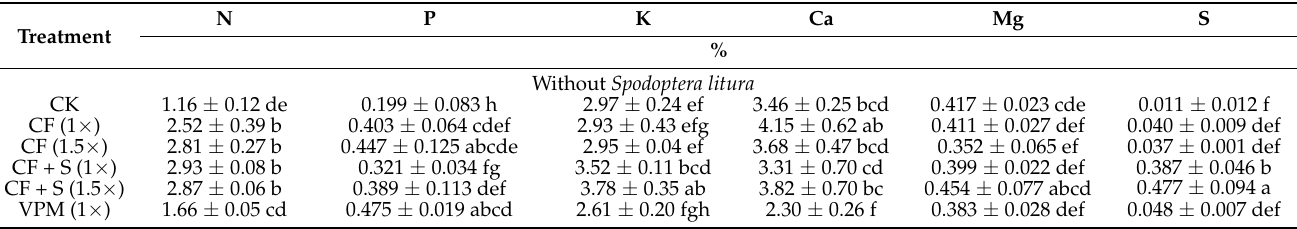
Table 4. The concentrations of nitrogen, phosphorous, potassium, calcium, magnesium, and sulfur in the leaves of Brassica chinensis grown in soils that received different treatments 1